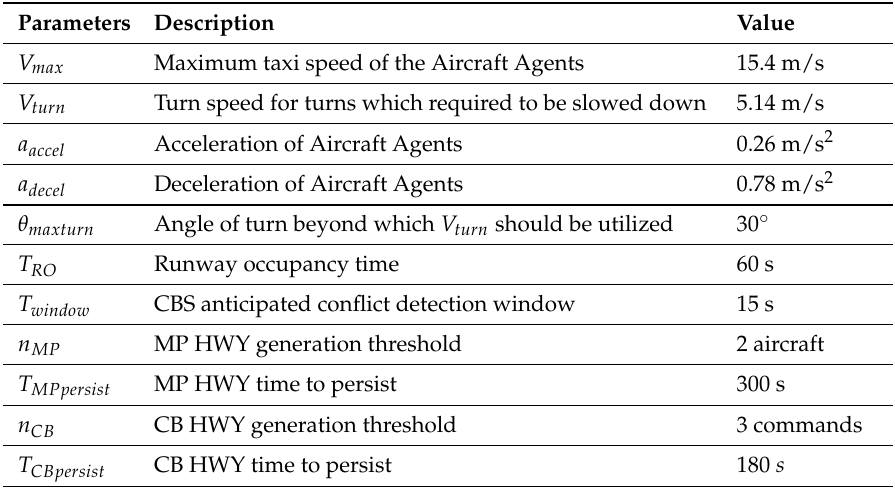
Table 2. Parameters used in the Multi-Agent System (MAS)